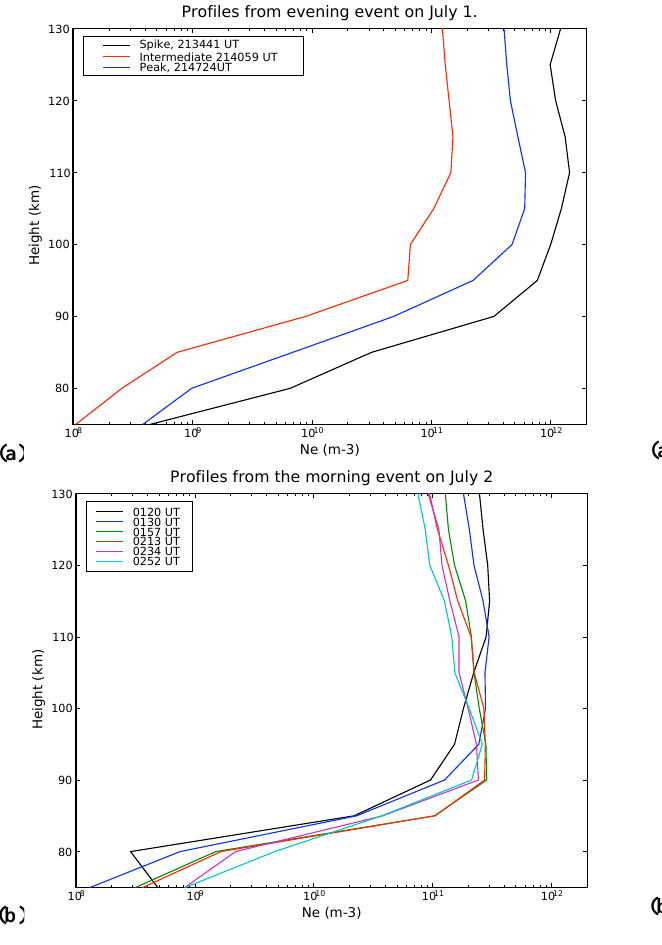
Fig. 6. (a) Spectra deduced from the profiles of Fig. 5a. (b) Spectra deduced from the profiles of Fig.